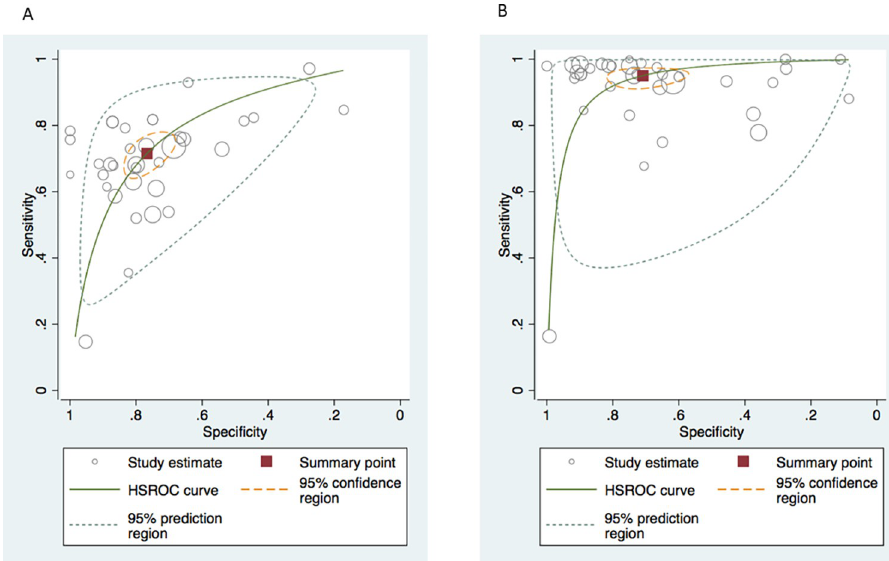
Fig 4. The HSROC of sensitivity and specificity for the Alvarado (A) and RIPASA (B) scores.